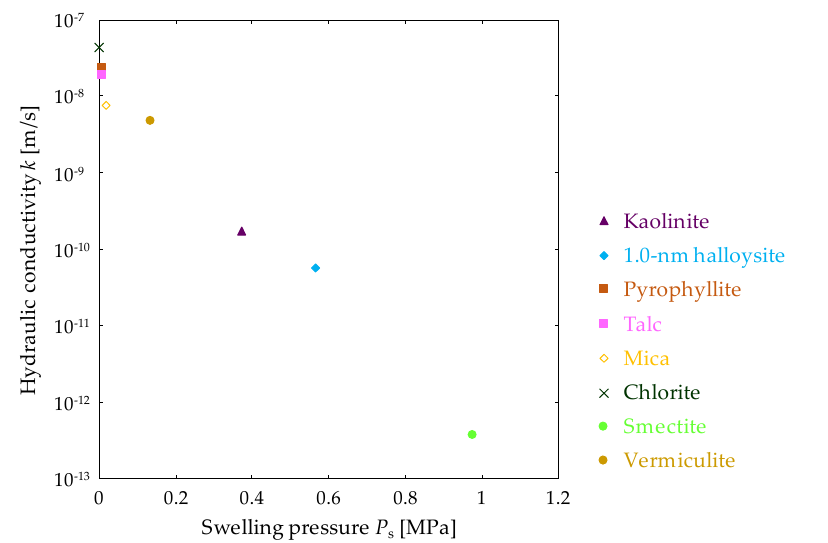
Figure 7. Relationship between swelling pressure and hydraulic conductivity of clay mineral samples (void ratio = 0.95).